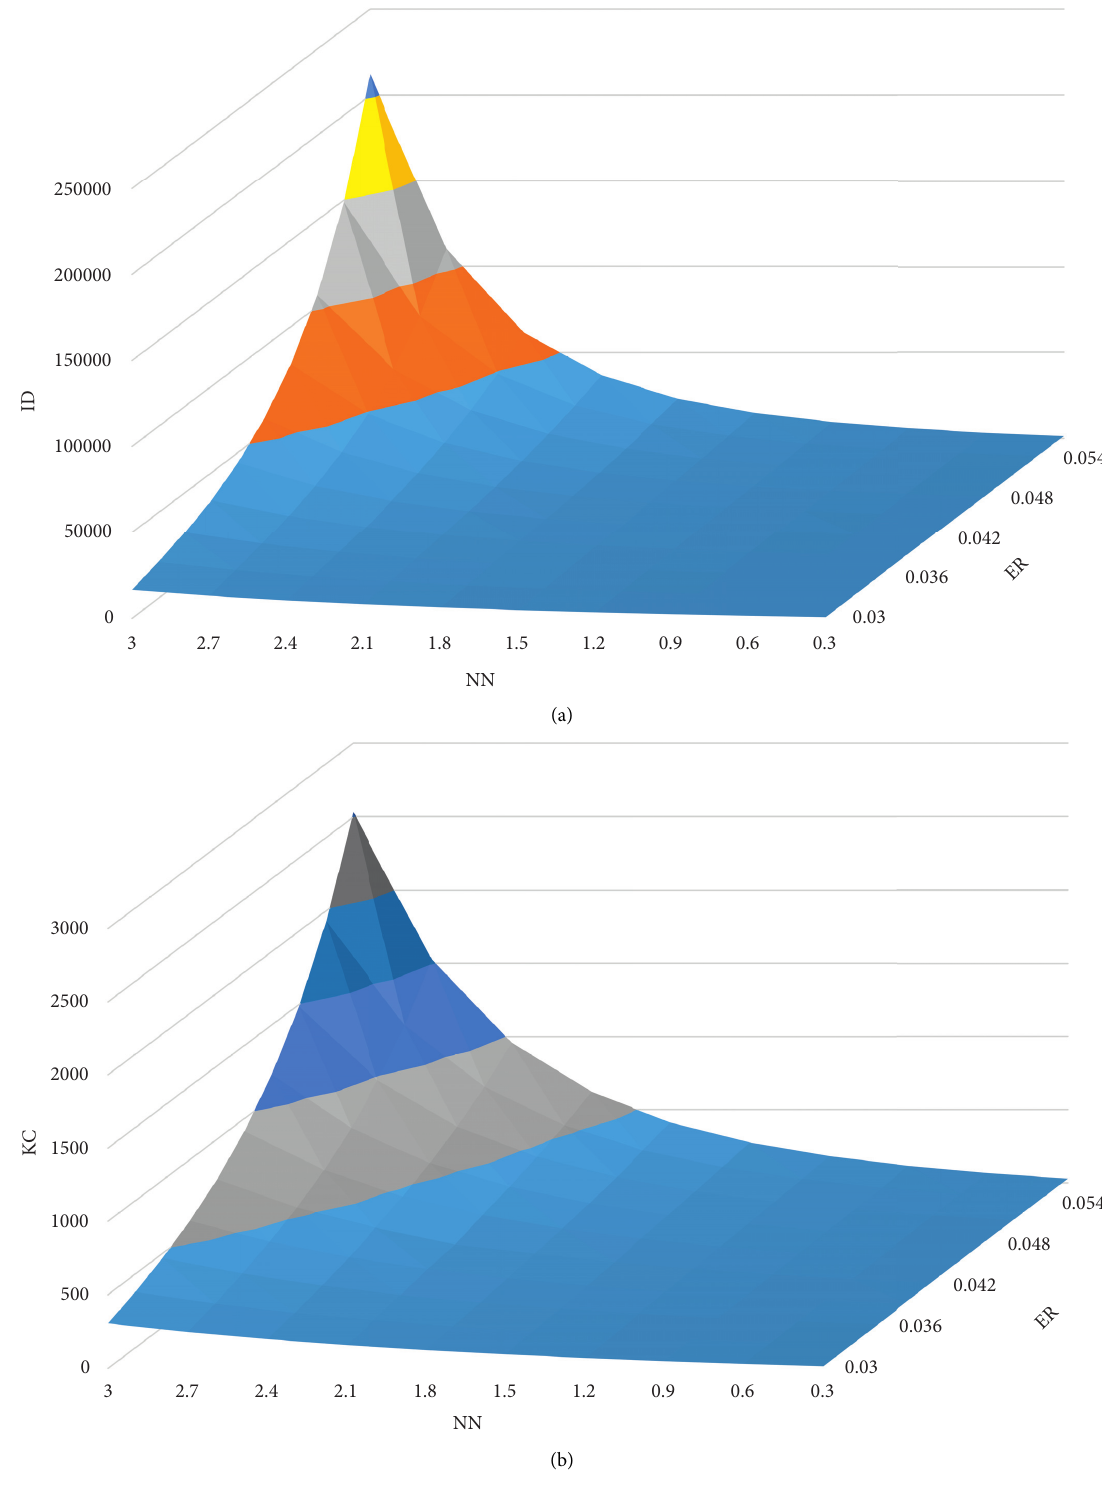
Figure 14: Values of IC and KC under different NNs and